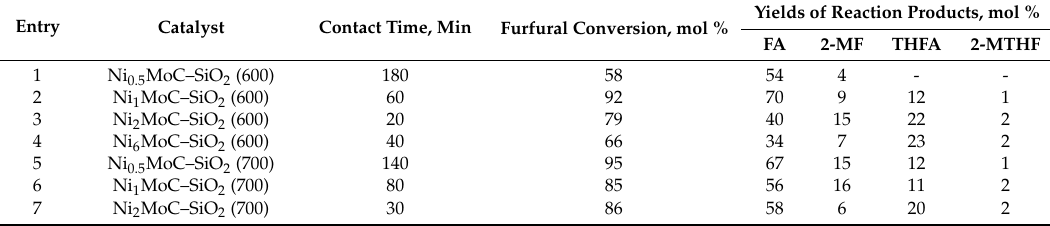
Table 1. The results of furfural hydrogenation over Ni–Mo carbide systems synthesized under various heat treatment conditions. Reaction conditions: T = 150 °C, P = 6.0 MPa, m cat = 1.000 g, and furfural/isopropanol molar ratio equal to 0.033.